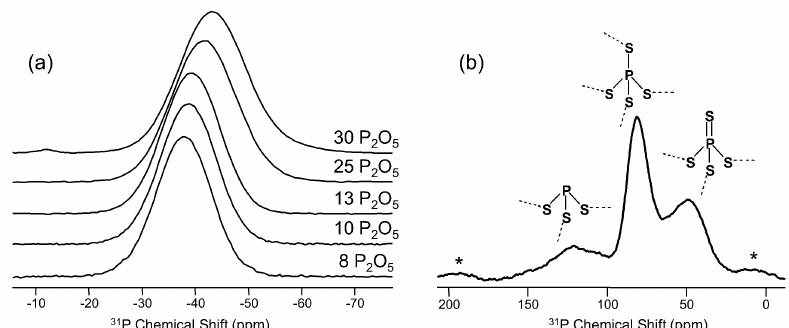
Figure 5. 31 P MAS NMR spectra for ( a ) a series of binary P 2 O 5 -SiO 2 glasses [29], with permission from Cambridge University Press. P 2 O 5 content in mol % is shown to the right of each trace. In ( b ) is 31 P MAS NMR data for a ternary sulfide glass with composition 10P 2 S 5 -6.7Ga 2 S 3 -83.3GeS 2 , adapted from [37] with permission from Elsevier. Different P polyhedra and their associated 31 P NMR resonances are labeled in ( b ), and asterisks denote spinning